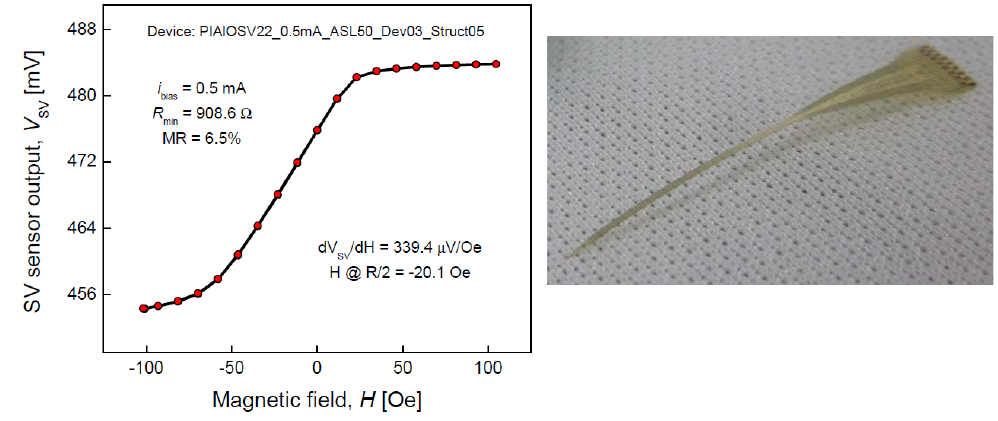
Figure 4. Spin valve devices deposited on polyimide as described in